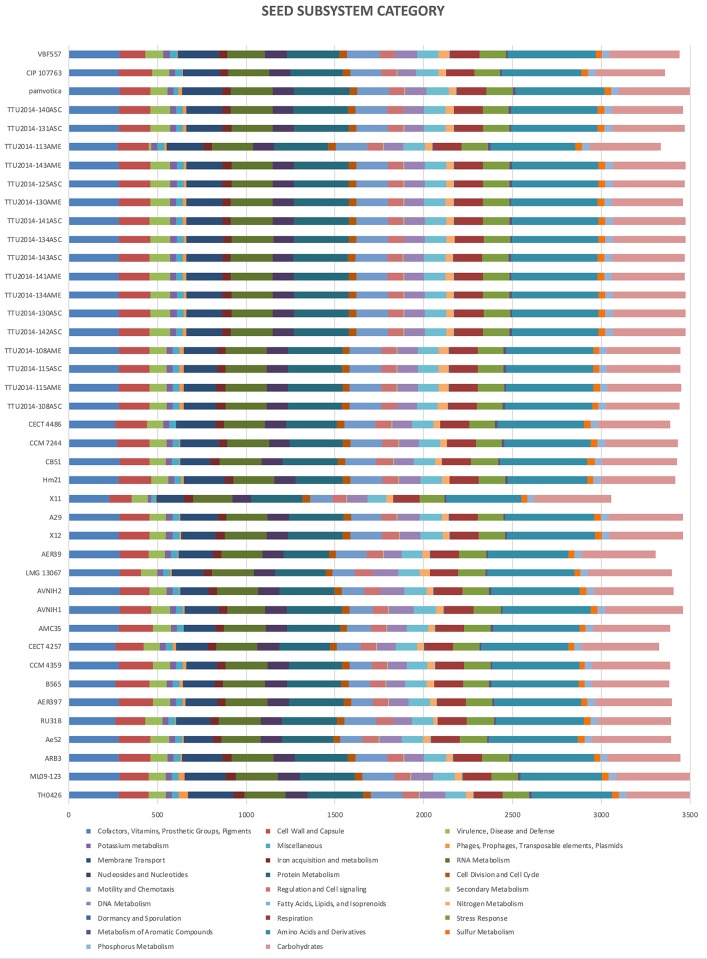
SEED subsystem category for A. veronii genomes.Comparison of functional categories in 41 A. veronii genomes based on SEED. Functional categorization is based on roles of annotated and assigned genes. Each colored bar represents the number of genes assigned to each category.